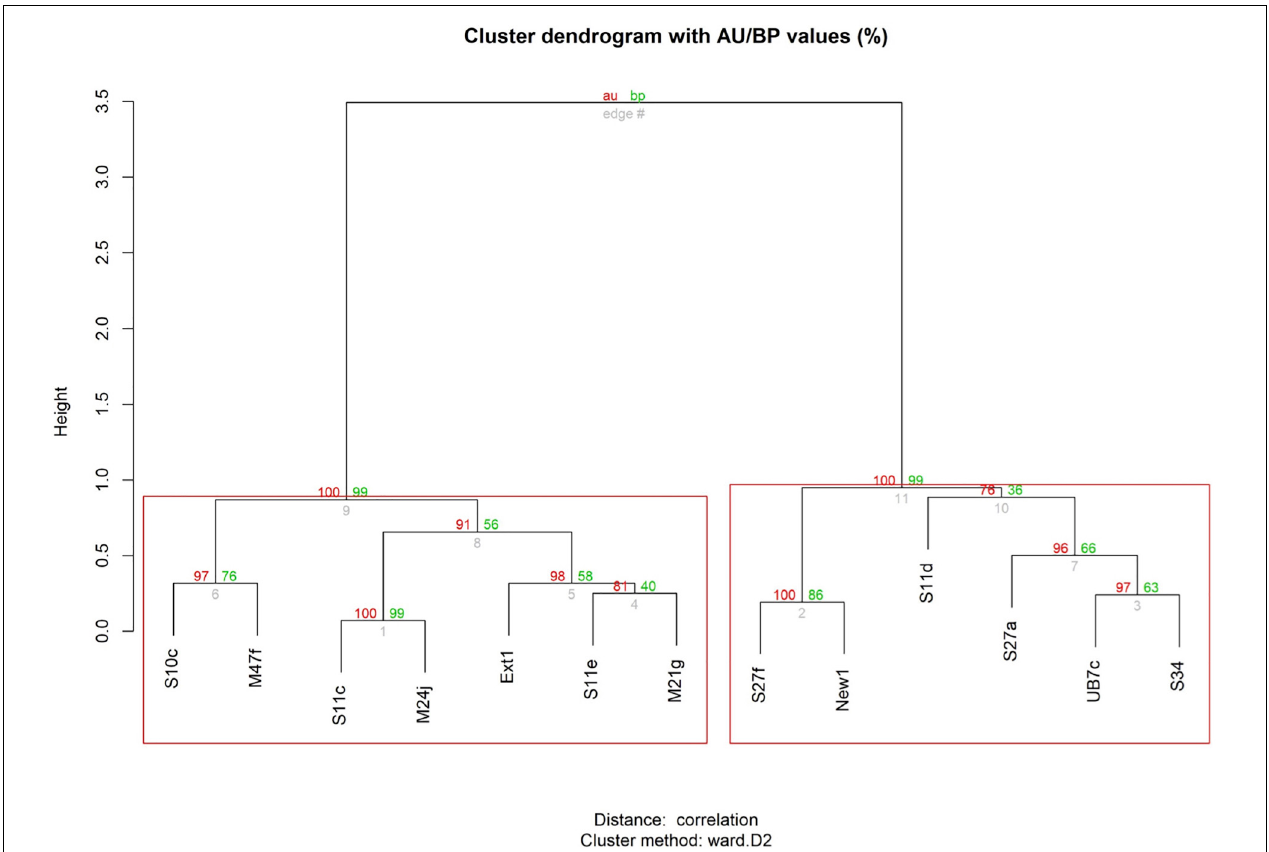
FIGURE 5 | Graphical representation of the results from the Dynamic Time Warping analysis, considering both relative position in the pod and breathing time, across all surveys. Values in red: indicate the Approximately Unbiased (AU) p -value, computed by multiscale bootstrap resampling. Values > 95 are strongly supported by data. Clusters with AU larger than 95% ( p -value < 0.05) are highlighted in red boxes. Values in green: represent bootstrap probability p -values, computed by normal bootstrap resampling. Height: a measure of the relative distance between